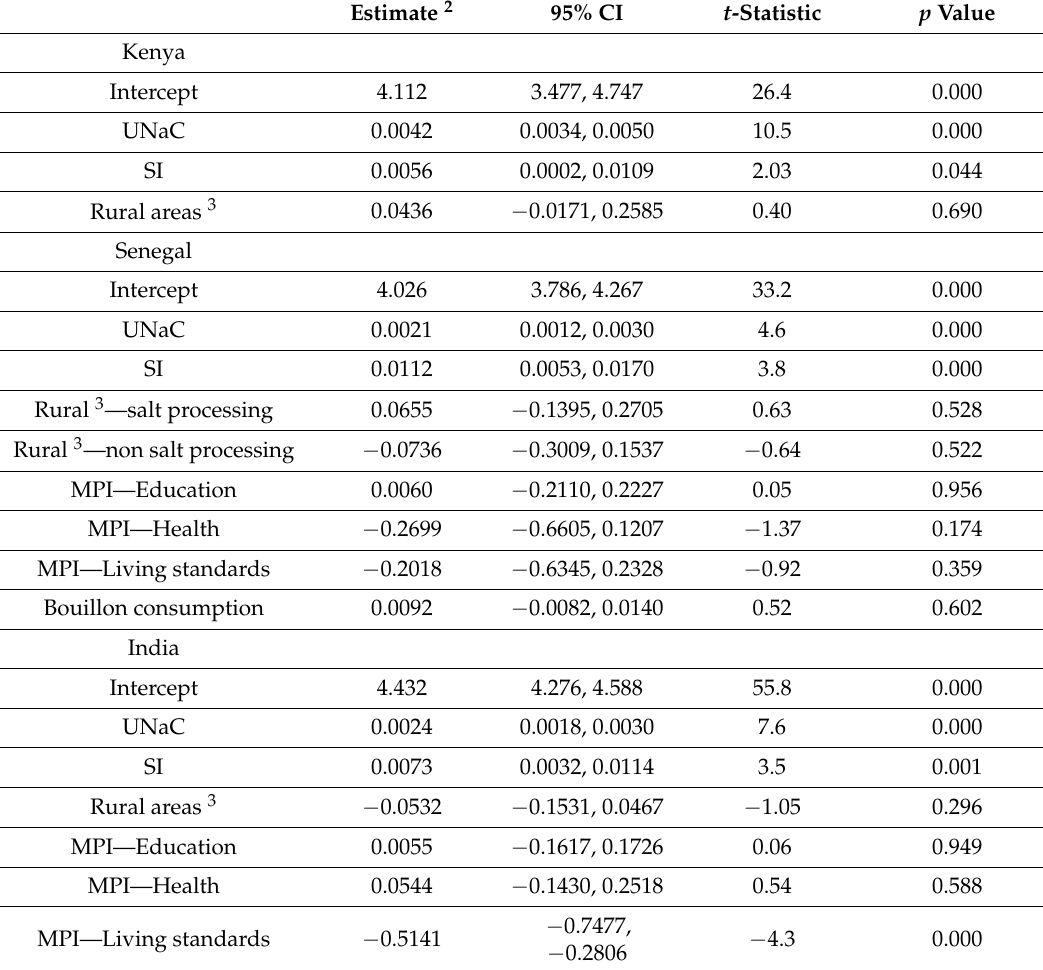
Table 2. Associations of UIC 1 in WRA with UNaC, SI and other explanatory variables by